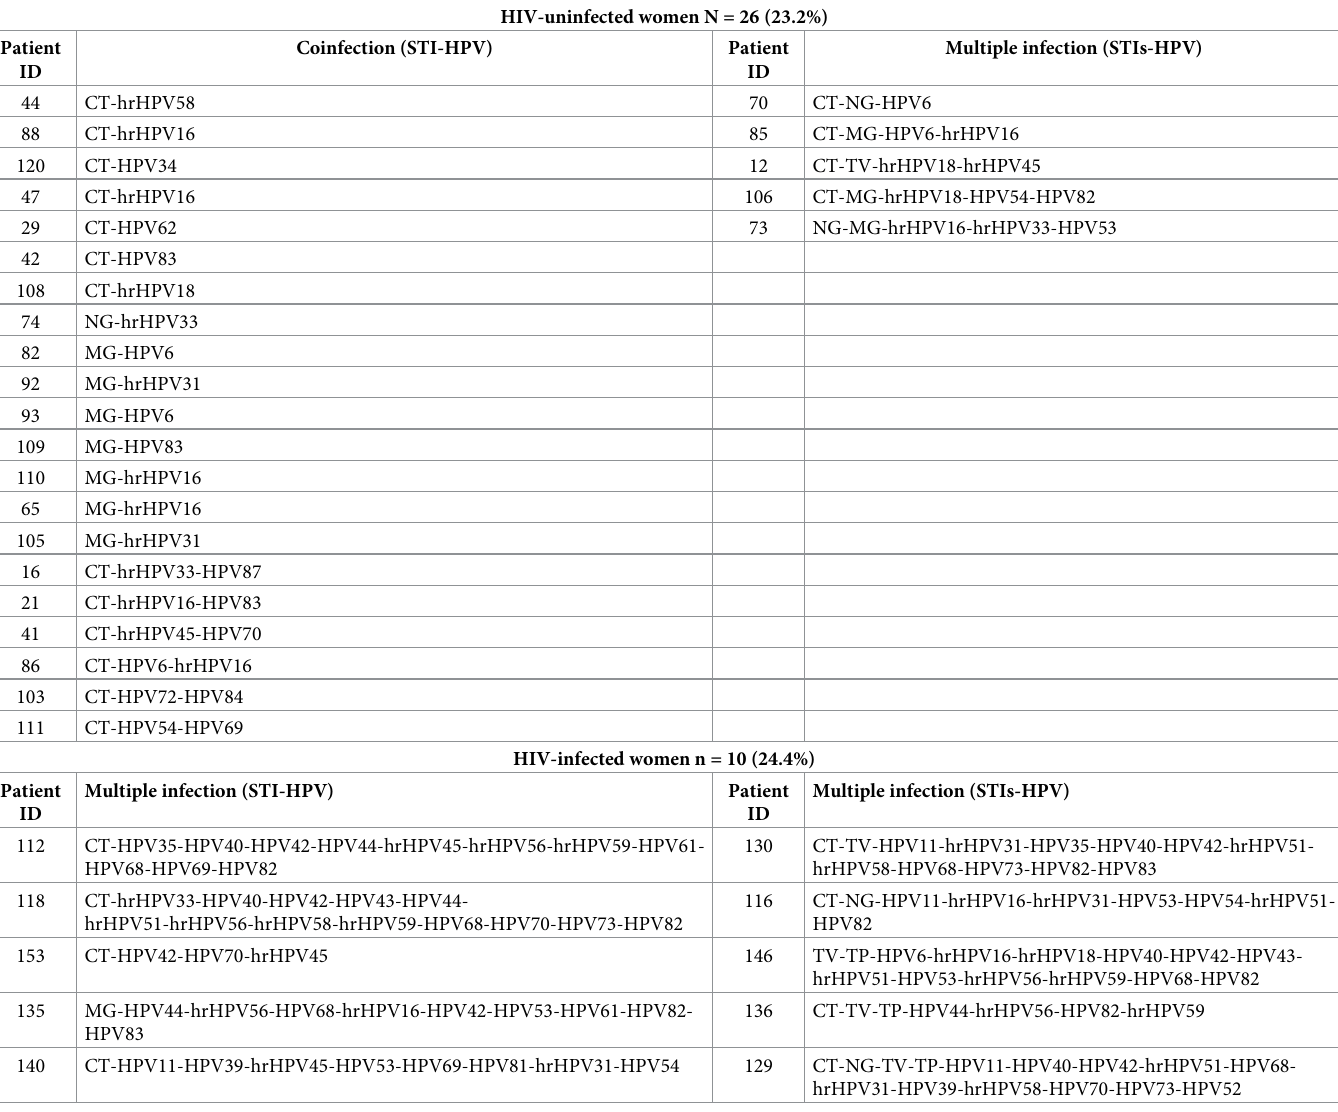
Table 4. Number and HPV types identified per woman with coinfection and multiple